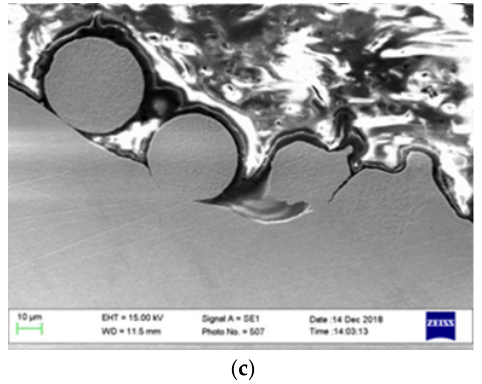
Figure 5. ( a ) Scanning electron microscopy (SEM) micro-image of the metal AM sample surface showing ( a ) the surface morphology with the fully melted material in the back ground, zones (1) and (2) show the BALLING effect and the partially melted and adhered neighboring particles, ( b ) shows the cross-section SEM micrograph view of the same surface, zone (3) shows unmelted powder particles, and (c ) shows a high magnification from the micrograph shown in ( b ).